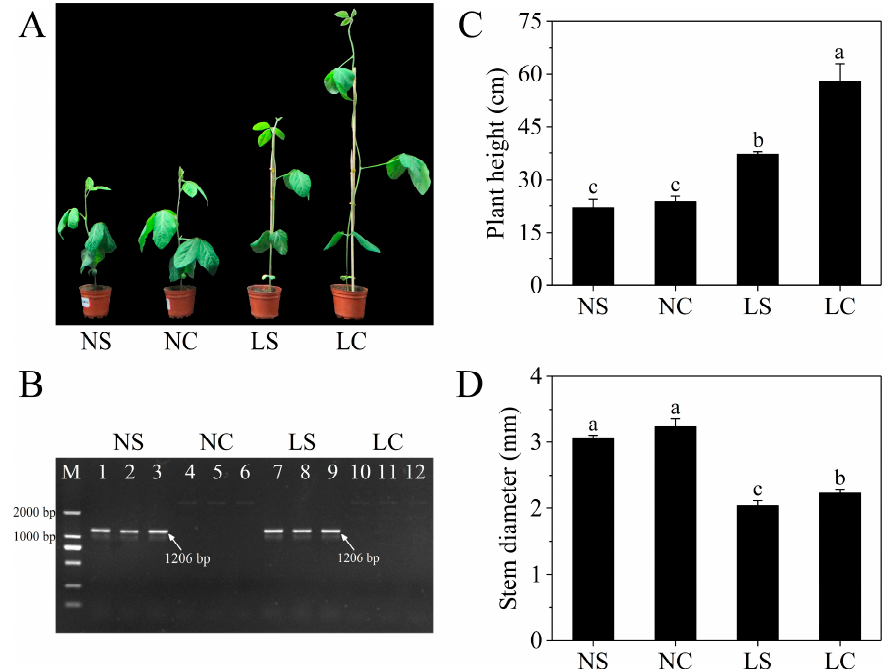
Figure 1. Plant phenotypes and soybean mosaic viris (SMV) detection after inoculation. ( A ) Soybean seedlings grown for 10 days after infection with SMV under di ff erent treatments. ( B ) RT-PCR detection to determine SMV infection. M: DNA Marker; 1–3: SMV infection under normal light (NS) plants; 4–6: Normal light (NC) plants; 7–9: SMV infection in the shade (LS) plants; 10–12: Control in the shade (LC) plants, respectively. ( C ) Plant height after 10 days of SMV infection; ( D ) Stem diameter after 10 days of SMV infection. Three independent experimental replicates were analyzed for each treatment, and data are indicated as the mean ± SE. The means for each treatment that do not have a common letter are significantly di ff erent at p = 0.05, according to Duncan’s multiple range test. NS and NC refer to SMV infection and control, respectively, under normal light, while LS and LC refer to SMV infection and control, respectively, in the